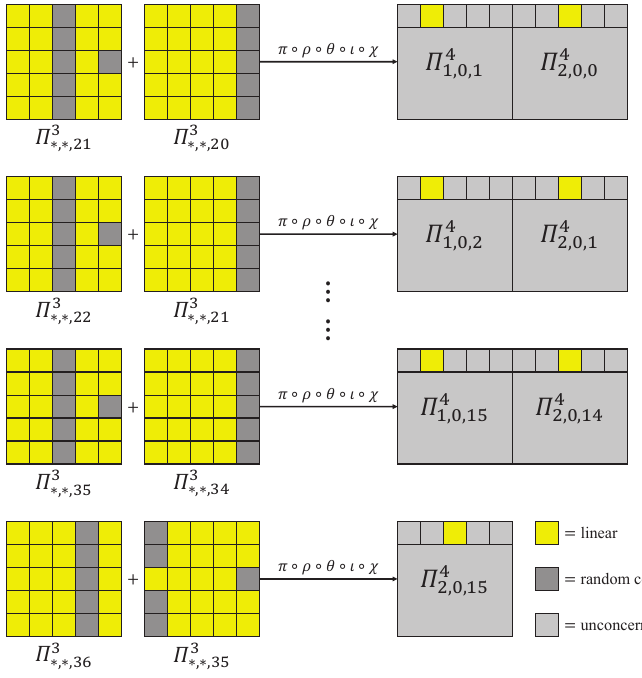
Figure 10: The modified freedom reuse